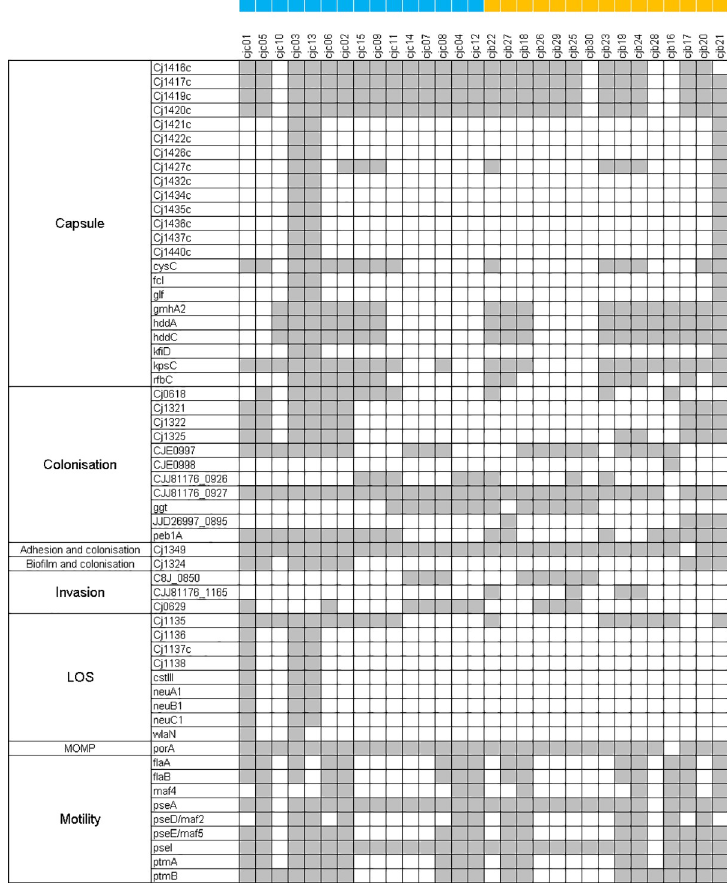
Fig 4. Prevalence (grey = present, white = absent) of virulence genes in broiler and human clinical C . jejuni isolates. Blue squares were placed beside clinical and orange squares were placed beside broiler isolates.